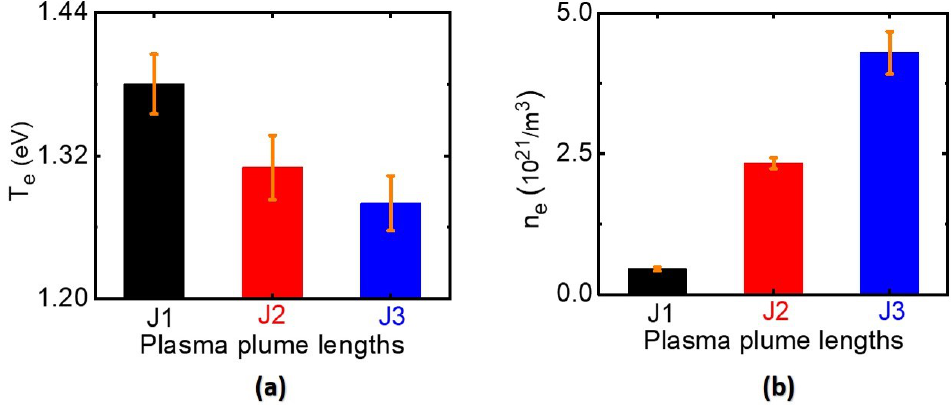
Figure 3. ( a ) Electron temperature and ( b ) electron density of the J1, J2, and J3